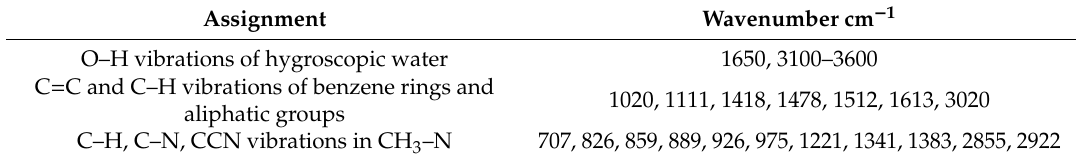
Figure 2. FTIR spectra of virgin anion exchangers in the OH - and ascorbate form: M/An ( a ) and G/An ( b ); starting hybrid polymers containing Cu 2 O: M/An/Cu 2 O ( a ) and G/An/Cu 2 O ( b ); and final products containing Cu 0 deposit: M/An/Cu ( a ) and G/An/Cu ( b ). Table 4. Assignments of infrared bands of the host anion exchangers